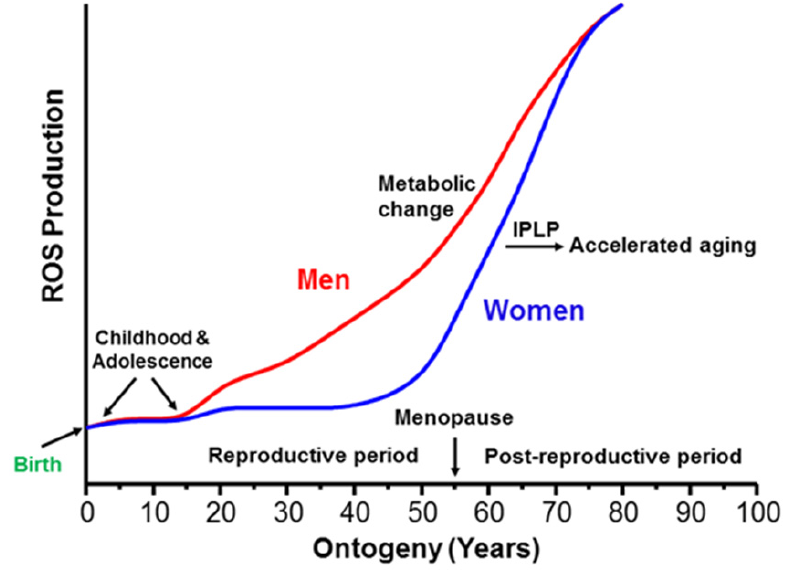
Figure 2. A schematic presentation of approximate differences between men and women in ROS production during ontogeny. The figure was adapted from ref [60].